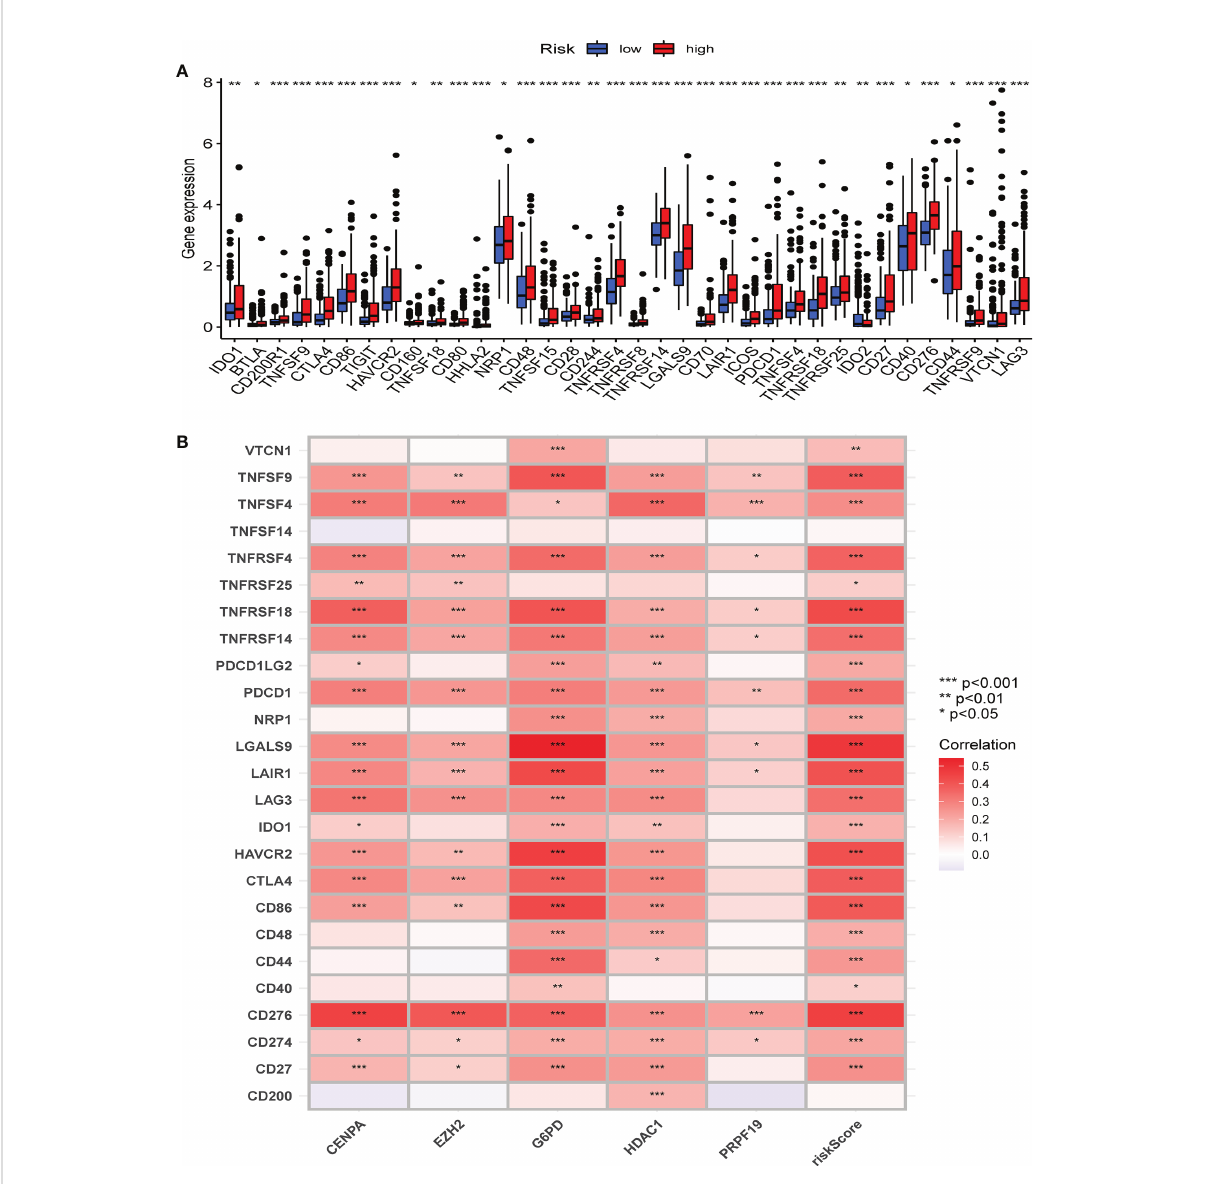
FIGURE 9 The correlation between immune checkpoint and the CS risk score. (A) The expression of the classic immune checkpoint genes between different risk groups. (B) The correlation heatmap between classic immune checkpoint genes, the fi ve CS signature genes, and the CS risk